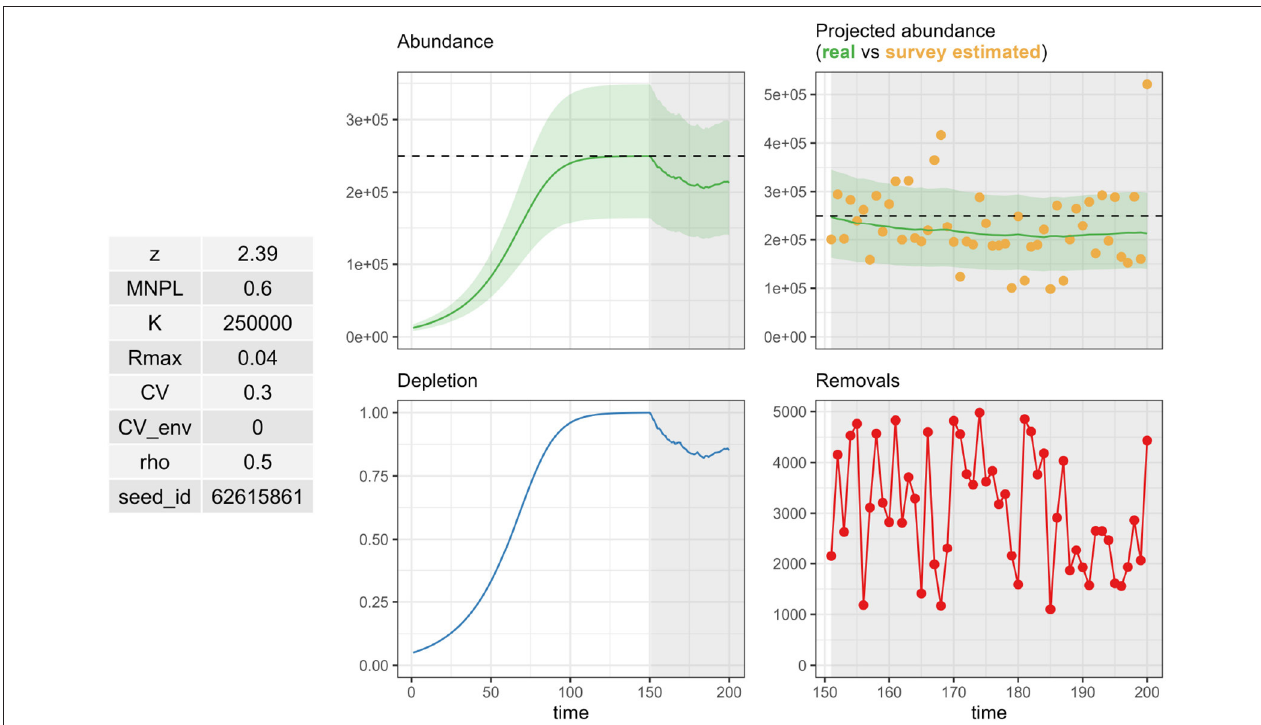
FIGURE 1 | Output from a call to summary_plot() on a pellatomlinson_pbr() output. Inputs are summarized on the left. Population dynamics are displayed in the middle, with either abundance (top) or depletion (bottom). Simulated survey estimates (top) and removals are displayed on the right subfigures.